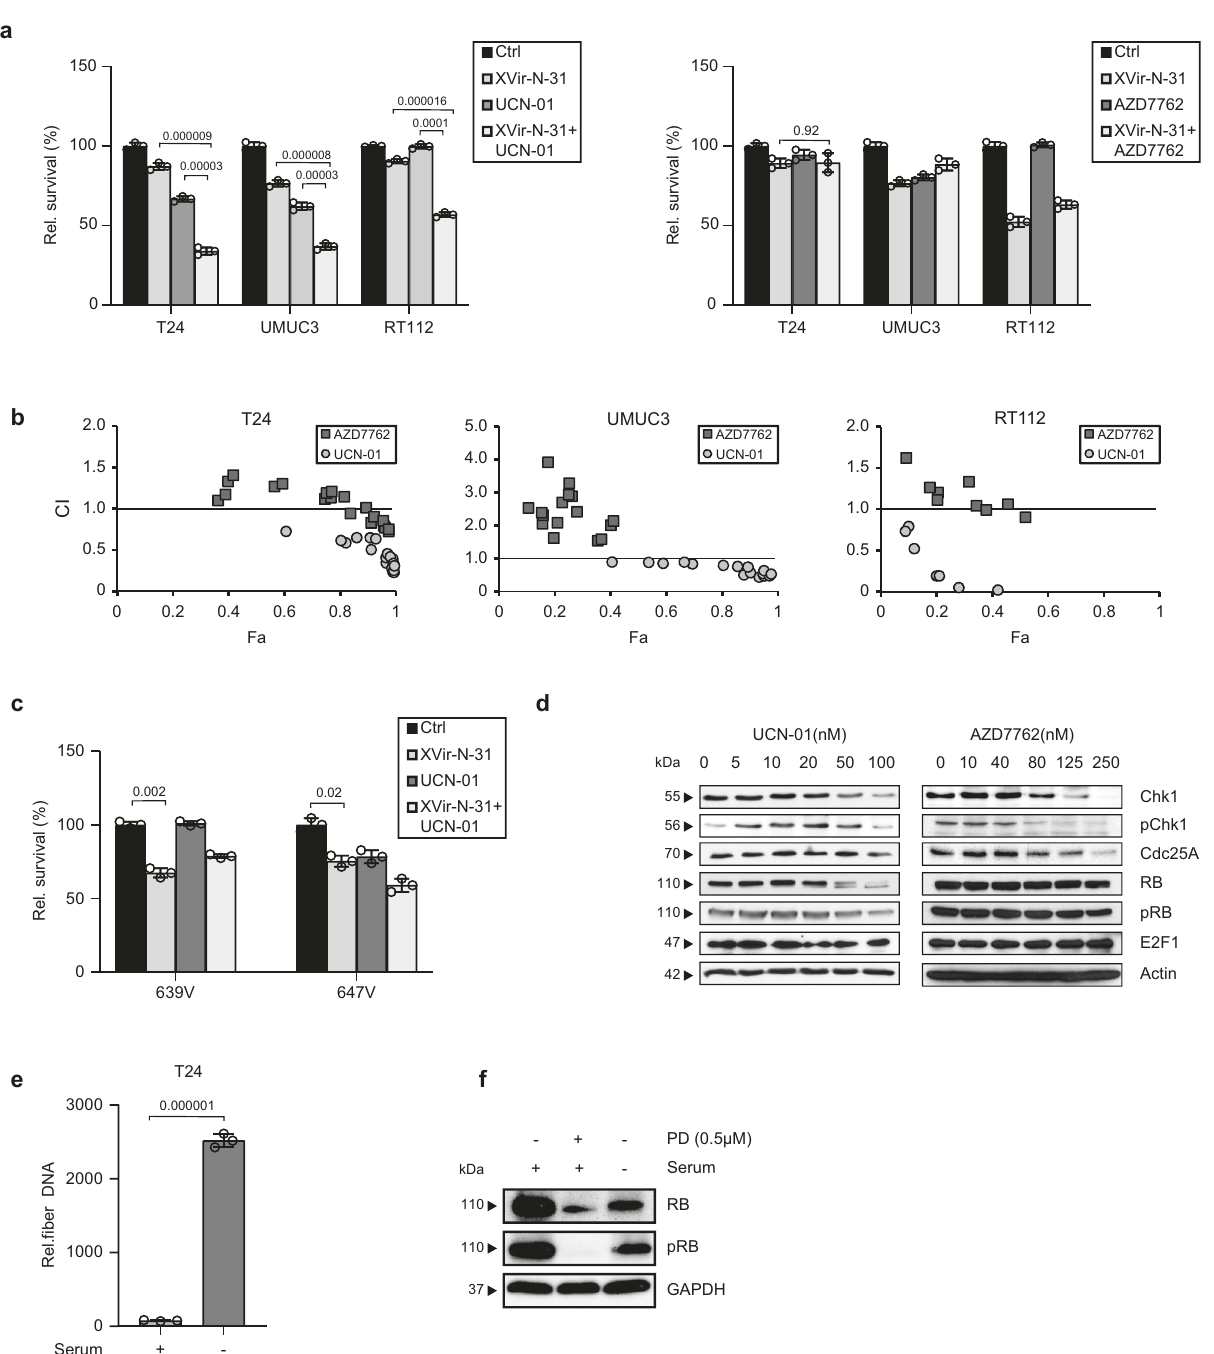
assessed at 4dpi. Data are shown as the percentage of surviving cells ( n =3, mean±SE) relative to non-infected, untreated control. p <0.05 d Protein expres- sion was analyzed by western blotting in T24 cells treated with increasing con- centrations of UCN-01 or AZD7762 for 24h. One representative blot is shown in three independent experiments. e Viralgenomereplicationwasassessedinserum- starved T24 cells infected with XVir-N-31 (MOI 50) by qPCR to amplify viral fi ber DNA at 24hpi. Data are represented relative to fi ber DNA at 4hpi as the baseline ( n =3, mean±SD). f Protein expression was analyzed by western blotting in T24 cells that were serum starved for 24h. One representative blot is shown in two independentexperiments.SDstandarddeviation,SEstandarderror,hpi/dpihours/ days post-infection, MOI multiplicity of infection. The statistical signi fi cance was determined by a two-sided Student ’ s t -test. n : number of biologically independent samples. Source data are provided as a Source Data fi